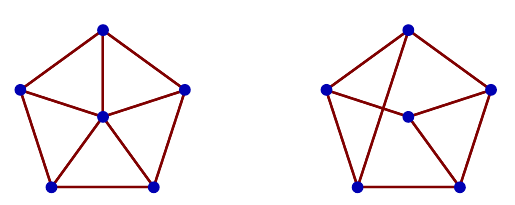
Figure 8 . ELC-equivalent (T-equivalent) graphs corresponding to the hexacode. These graphs have Q = 2 x 4 (11 x 2 + 16 xy + 5 y 2 ) .